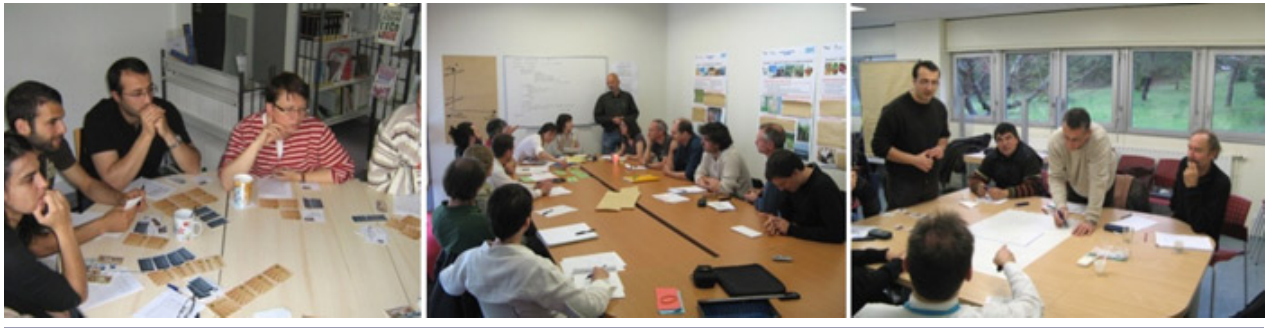
Fig. 1. Illustration of the simulation phase, where participants role-play a participatory